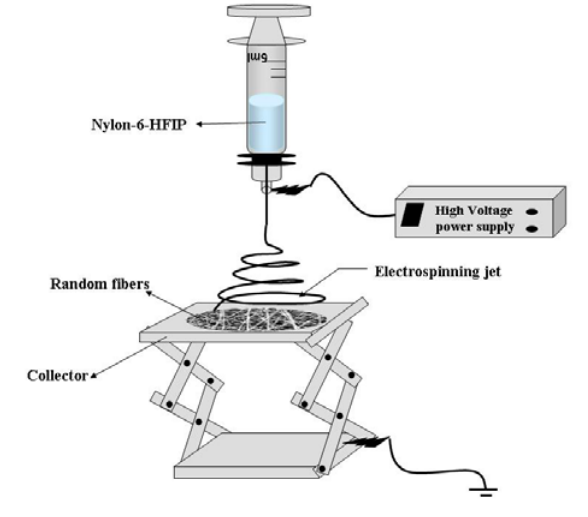
Figure 2. Schematic of the electrospinning process to obtain the Nylon-6 nanofiber mat. Solution of 7 wt% Nylon-6 in HFIP has been electrospun by feeding through a